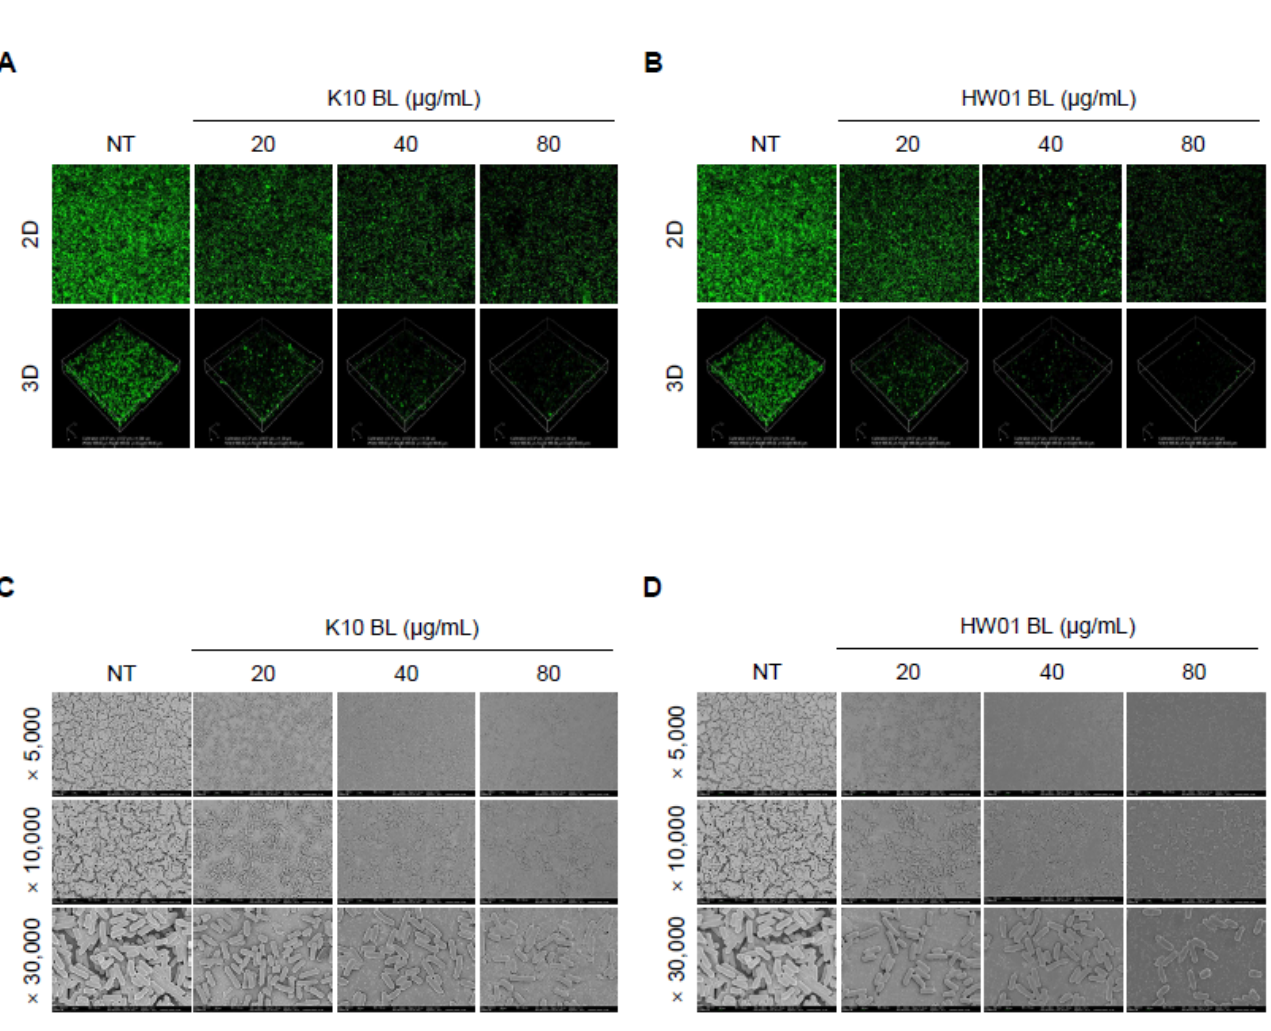
Figure 2. Disruption of L. monocytogenes biofilm formation by P. acidilactici BLs. K10 BL or HW01 BL (0, 20, 40, and 80 μ g/mL) was preincubated at 37 °C for 3 h on cover glasses, after which L. monocyto- genes (1 × 10 7 CFU/mL) was added and incubated at 37 °C for an additional 24 h. Biofilm formation was then analyzed using confocal laser scanning microscopy ( A , B ). For scanning-electron-micro- scopic analysis, K10 BL or HW01 BL (0, 20, 40, and 80 μ g/mL) was preincubated at 37 °C for 3 h on coverslips, and L. monocytogenes (1 × 10 7 CFU/mL) was then added and incubated at 37 °C for an additional 24 h. Samples were then analyzed using scanning electron microscopy at 5000, 10,000, and 30,000 × magnifications ( C , D ). All images taken from one of three similar results are shown. 3.2. Antibiofilm activity of P. acidilactici BL is not affected by the viability of L. monocytogenes .